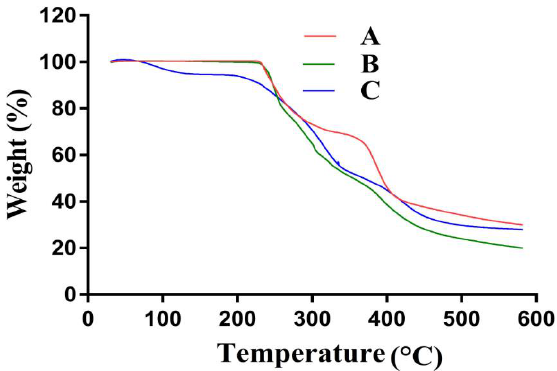
Figure 5. TGA of ( A ) ASPA, ( B ) AMPS, and ( C ) ASPA-pAMPS microgels (AFn-3).